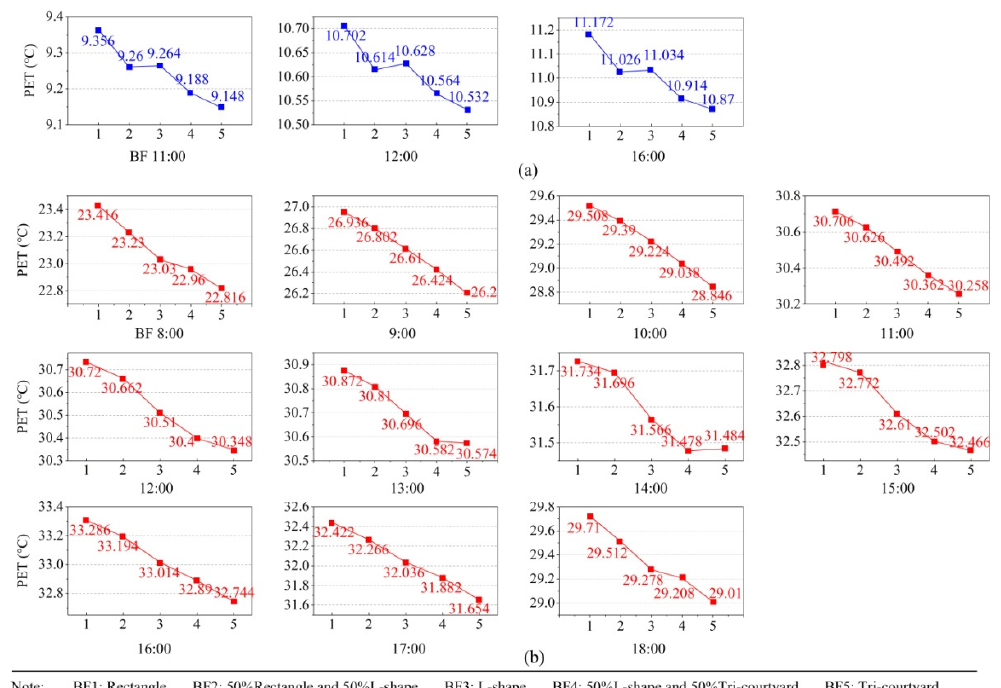
Figure 11. Effect diagrams of building form (BF) in summer: ( a ) effect diagrams of BF in winter and ( b ) effect diagrams of BF in summer.